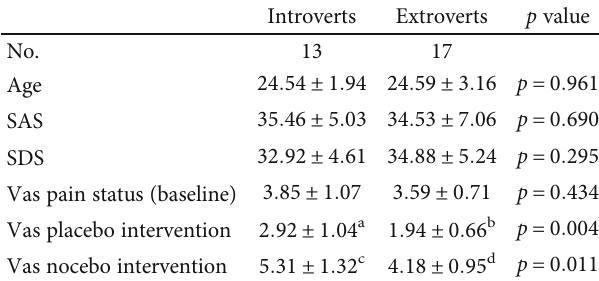
Figure 4: The experimental paradigm (Scan Session) for the Table 1: Summary of characteristics of the 30 subjects.